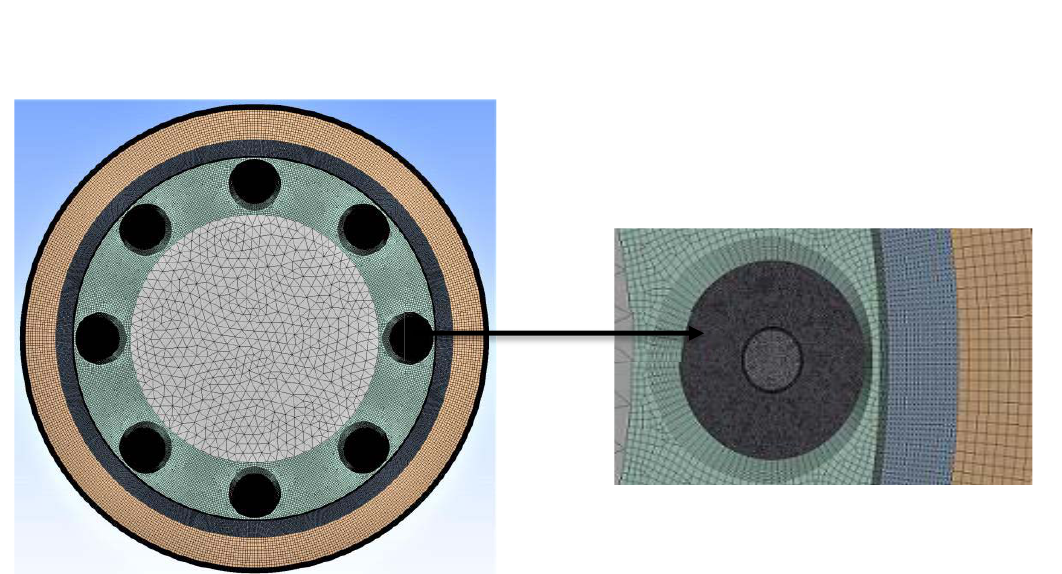
Figure 3. Mesh geometry of Test section